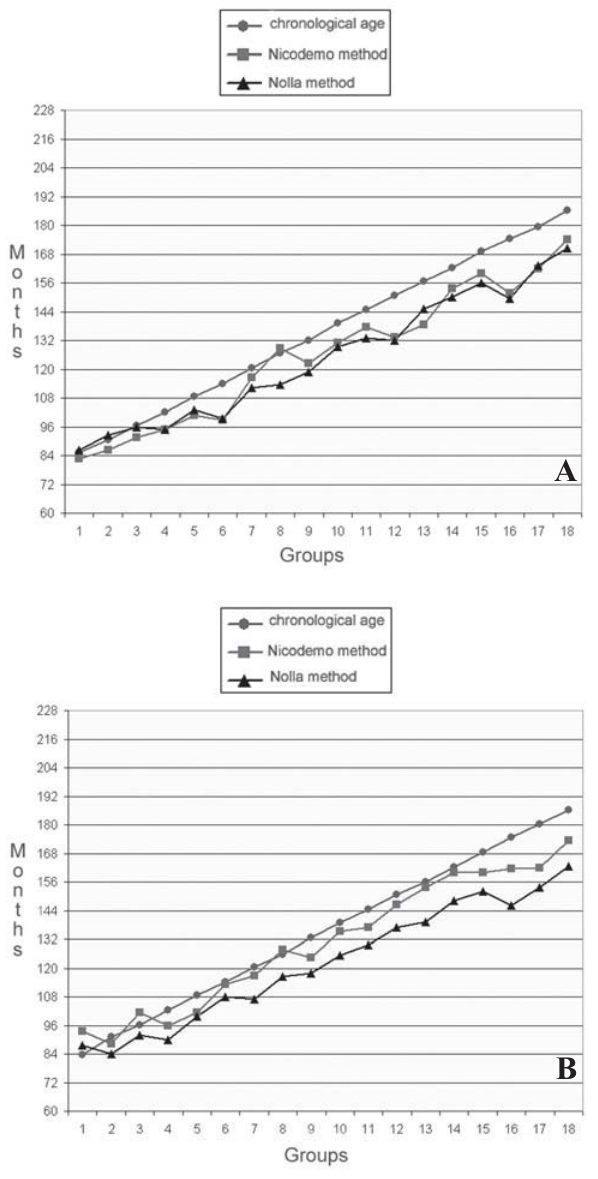
FIGURE 1- Correlation between chronological and estimated dental age using the methods proposed by Nolla and Nicodemo, et al. A: males; B: